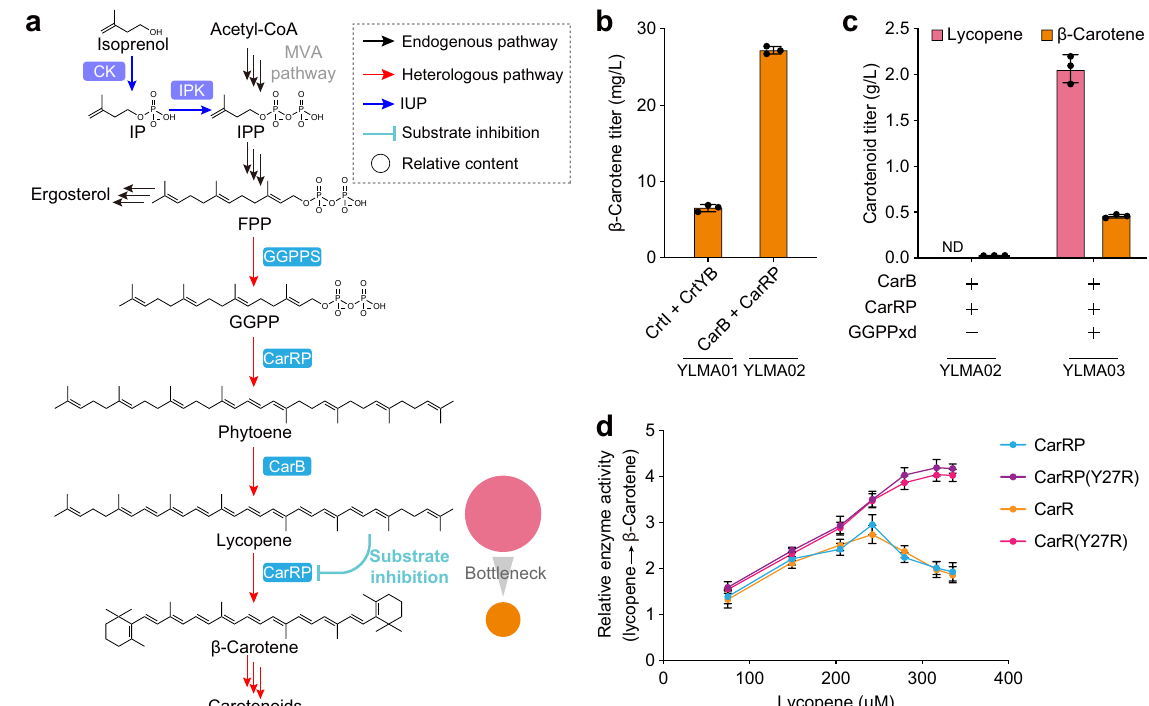
Fig. 1 lycopene cyclase shows the substrate inhibition effect. a Lycopene inhibits its downstream enzyme, lycopene cyclase, through substrate inhibition. Consequently, a higher lycopene formation rate than its subsequent conversion rate into β -carotene could aggravate the imbalance, leading to the build-up of lycopene. IP isopentenyl phosphate, IPP isopentenyl diphosphate, FPP farnesyl diphosphate, GGPP geranylgeranyl diphosphate, CK Choline Kinase, IPK Isopentenyl Phosphate Kinase. b After 3 days of fermentation in YPD media, β -carotene levels in strains expressing relevant biosynthetic genes from different sources indicated that the CarB/CarRP pair reached higher levels of performance. c Heterologous overexpression of GGPP synthase from X. dendrorhous (GGPPxd) increased β -carotene production but also led to the major accumulation of lycopene, its biosynthetic precursor. ND not detected. d Measurements of relative lycopene cyclase catalytic activity indicated that the activity of wild type CarRP (or CarR) was biphasic with respect to lycopene concentration, indicating substrate inhibition. By contrast, the CarRP (or CarR) variant Y27R was completely free of substrate inhibition. CarR, truncated CarRP without P domain. For b to d , the average and standard deviation (s.d.) of three biologically independent experiments are shown. Source data are provided as a Source Data fi